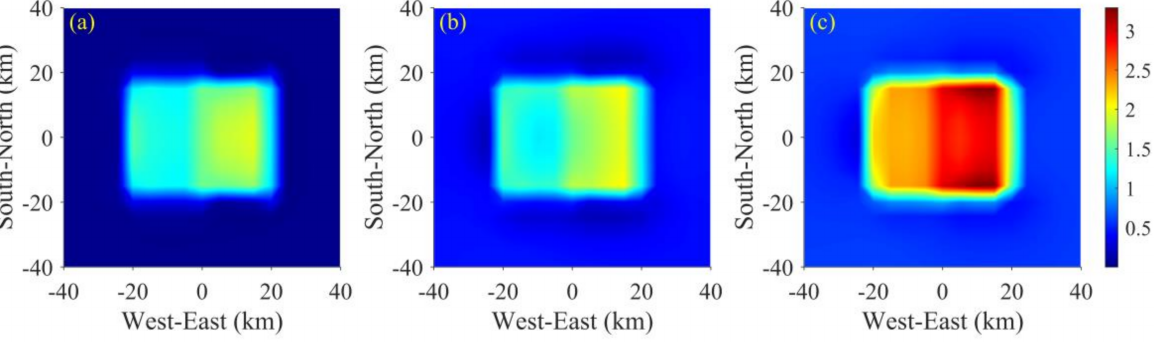
Figure 17. Anisotropy index of modified COMMEMI 3D-2A model. ( a ) 0.1 Hz. ( b ) 0.01 Hz. ( c ) 0.001